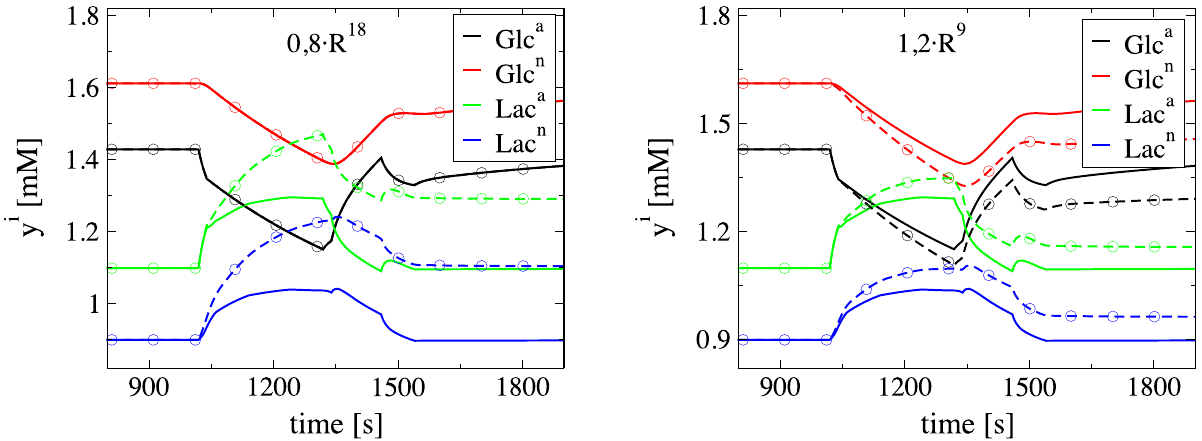
Fig 6. Response of Glc a , n and Lac a , n in decrease/increase of R 18 / R 9 . Evolution of Glc a , n and Lac a , n during neuronal activation. Comparison of the solution under normal conditions (solid lines) with the one under perturbed rates conditions (dashed lines with circles). Left: Decrease of R 18 by 20%. Right: Increase of R 9 by